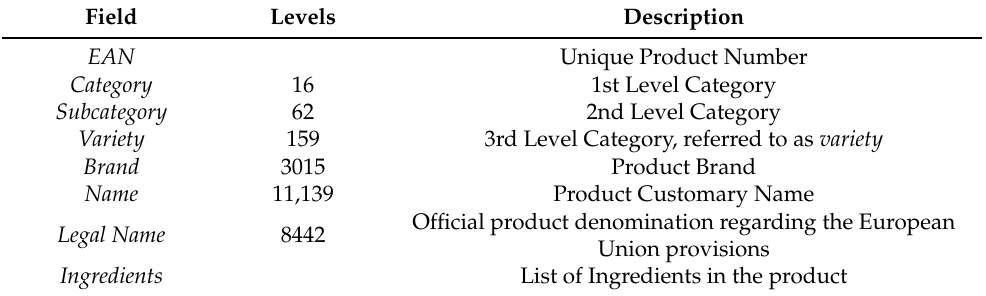
Table 2. Product attributes in the dataset.